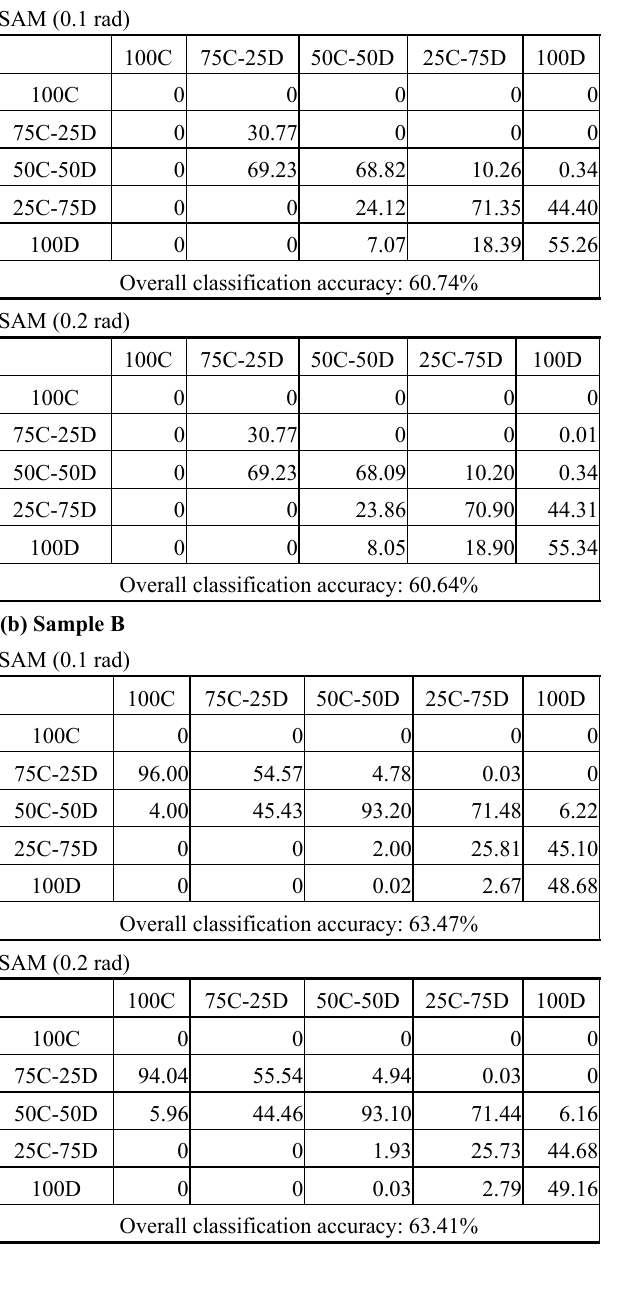
Table 2. Confusion matrix of the classified carbonate mineral mixtures by comparing spectral angle mapper (SAM) and linear spectral unmixing (LSU) results with wavelength position results. Samples ( a ) A, ( b ) B, ( c ) C, and ( d ) D. (C = calcite and D = dolomite, prefix numbers showing the mineral contents in percent).